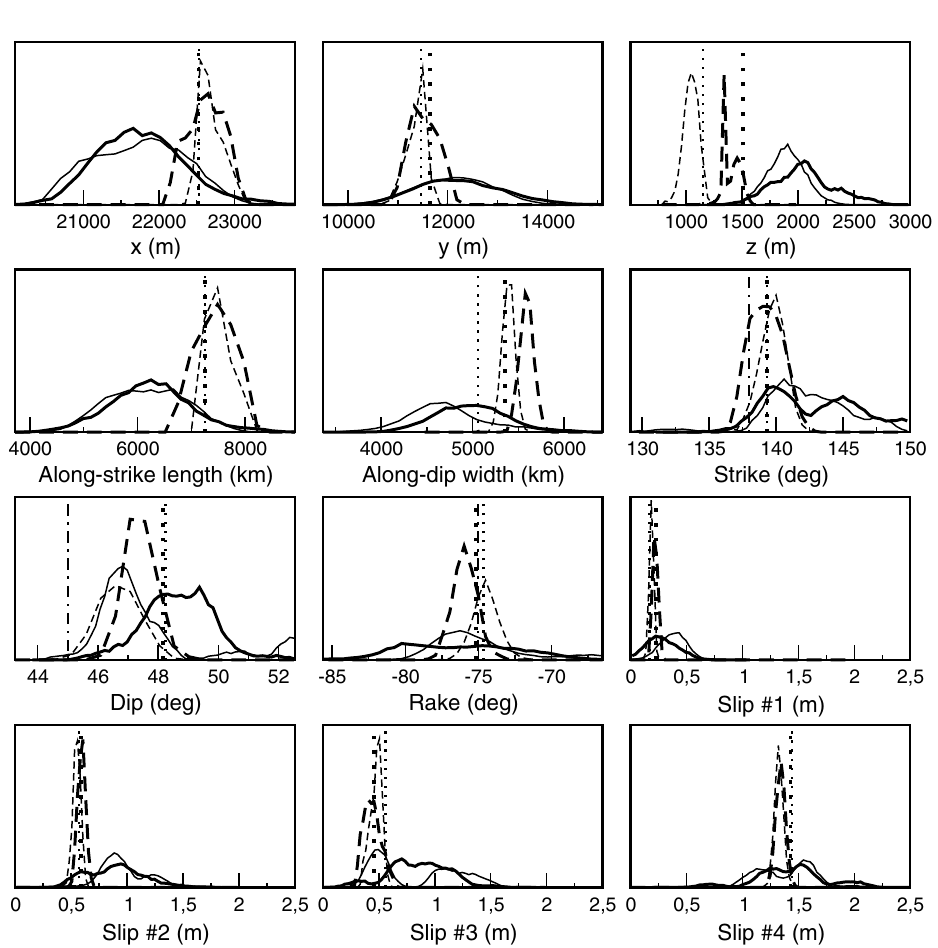
Fig. 8. PDFs of inferred fault parameters in the HHS (thin lines) and LHS (thick lines): dashed lines, bootstrap- ping; solid lines, NAB. Vertical dotted lines show ASA best-fit values; vertical dash-dotted lines indicate true parameter values. 2 × 2